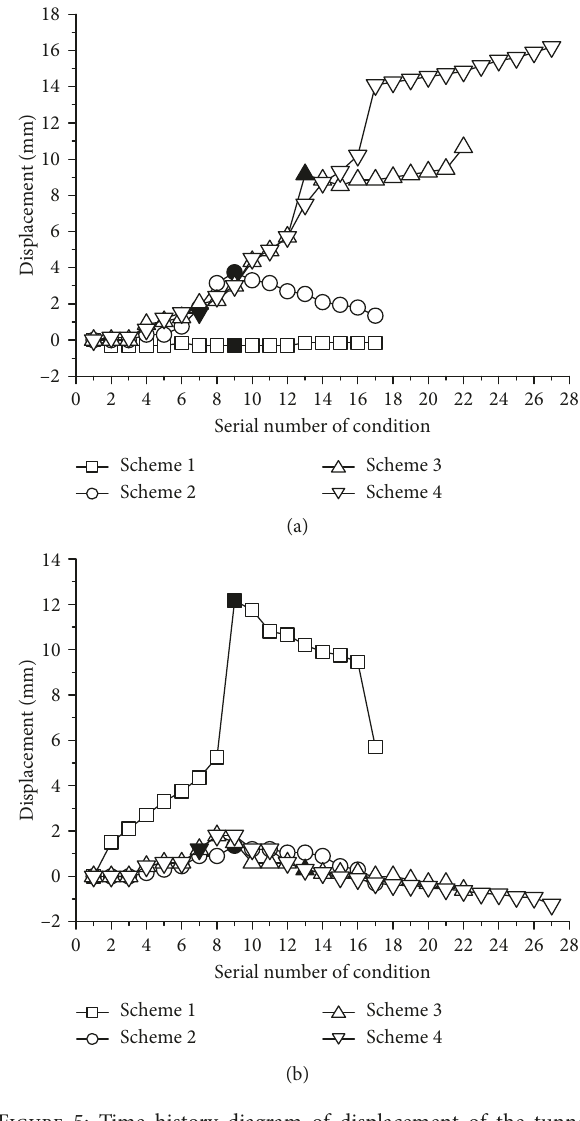
Figure 5: Time history diagram of displacement of the